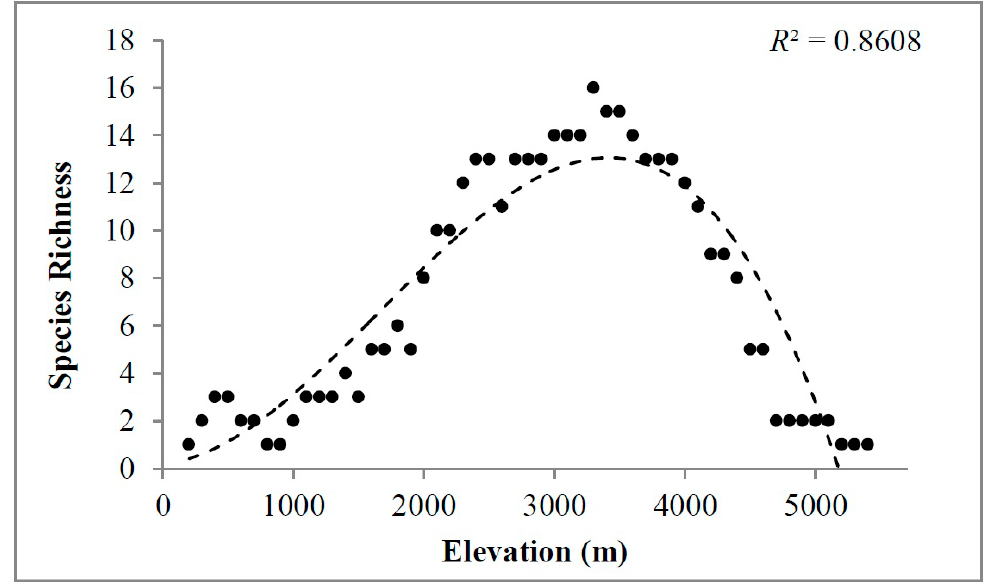
Figure 2. Species richness of gymnosperms in Nepal (solid dots) with the highest fit of the polynomial curve (dash line). R 2 represents the explanatory power of the regression model significance at p < 0.005.